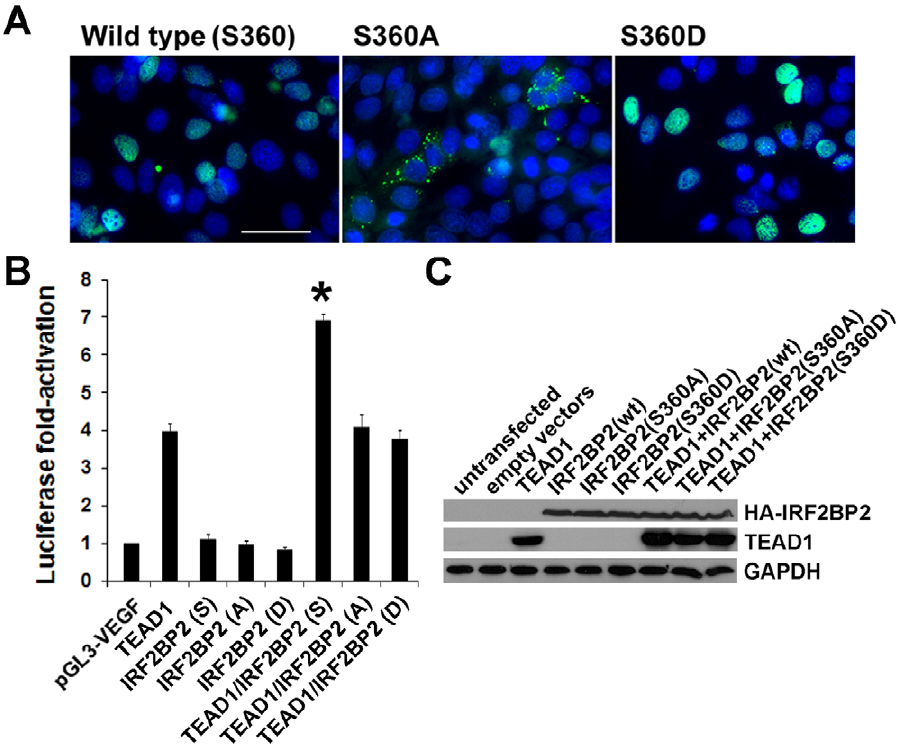
Figure 5. Despite forced nuclear retention the S360D mutant did not produce a dominantly active form of IRF2BP2. A. The S360A mutant of IRF2BP2 was cytoplasmic and the S360D mutant was nuclear in CV1 cells. Scale bar, 50 m m. B. The wild type IRF2BP2 augmented TEAD1- dependent activation of the mouse VEGFA promoter in CV1 cells (asterisk, p , 0.05). The S360A and the S360D both failed to co-activate VEGFA when co-expressed with TEAD1. N=3 experiments. C. Immunoblot analysis of protein lysates from transfected CV1 cells revealed similar levels of wild type and mutant IRF2BP2 proteins.